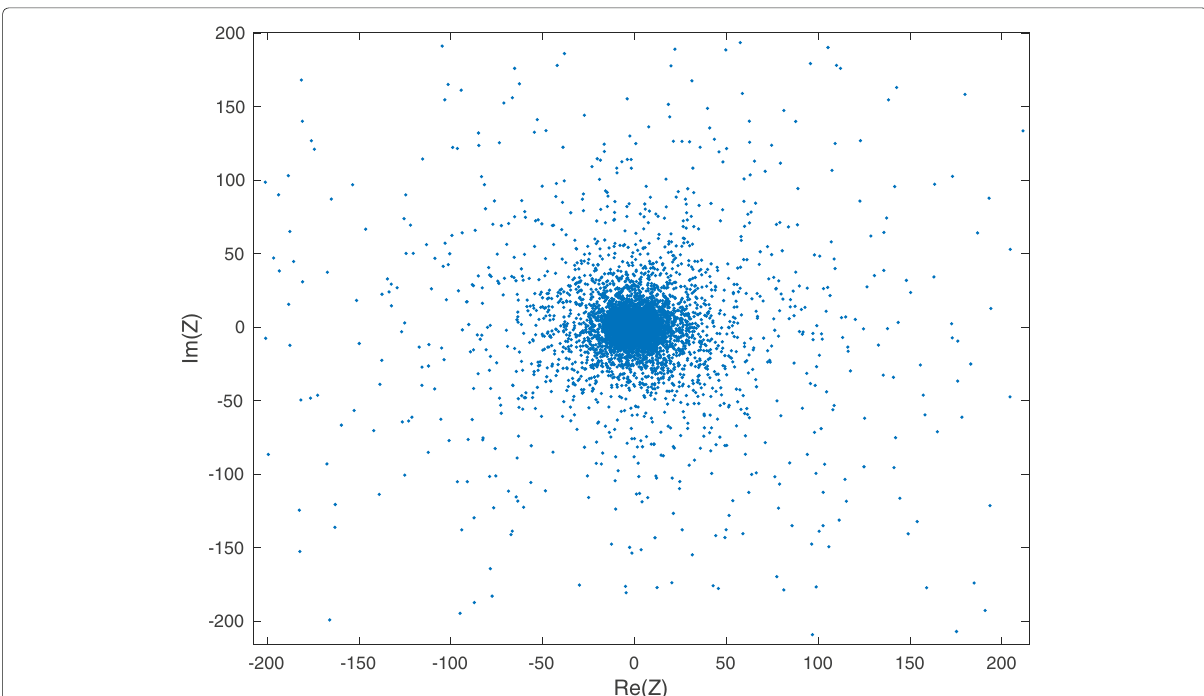
Fig. 1 Scatter plot of samples from the real and imaginary parts of interference on a single band. Samples generated from a network of devices distributed uniformly on a disc of radius R = 500 m and number of access points drawn from a Poisson distribution with parameter π R 2 λ with λ =